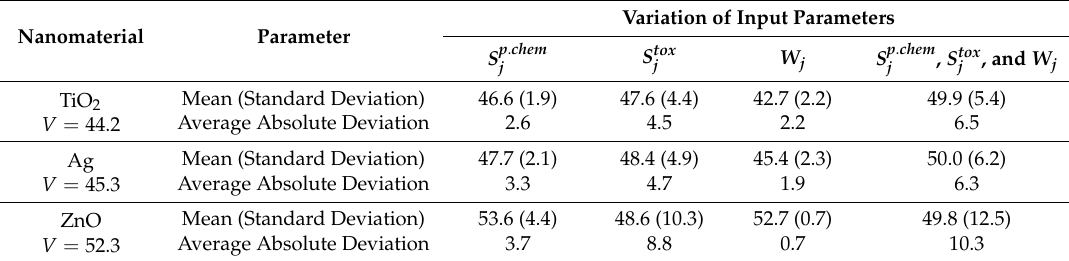
Table 6. Results of Monte Carlo sensitivity analysis for quantitative WoE methodology displaying the mean, standard deviation, and average absolute difference of the total weighted index value ( V ) from 10,000 simulations for each uncertainty scenario proposed; (i) variation of physico-chemical input parameters, (ii) variation of toxicity parameters, (iii) variation of study weight parameters, and (iv) variation of all (i)–(iii)